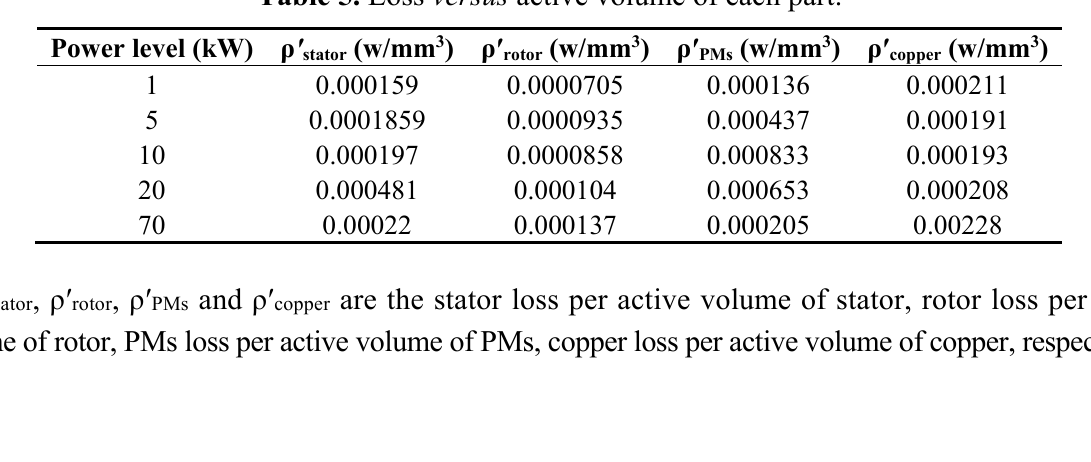
Table 5. Loss versus active volume of each